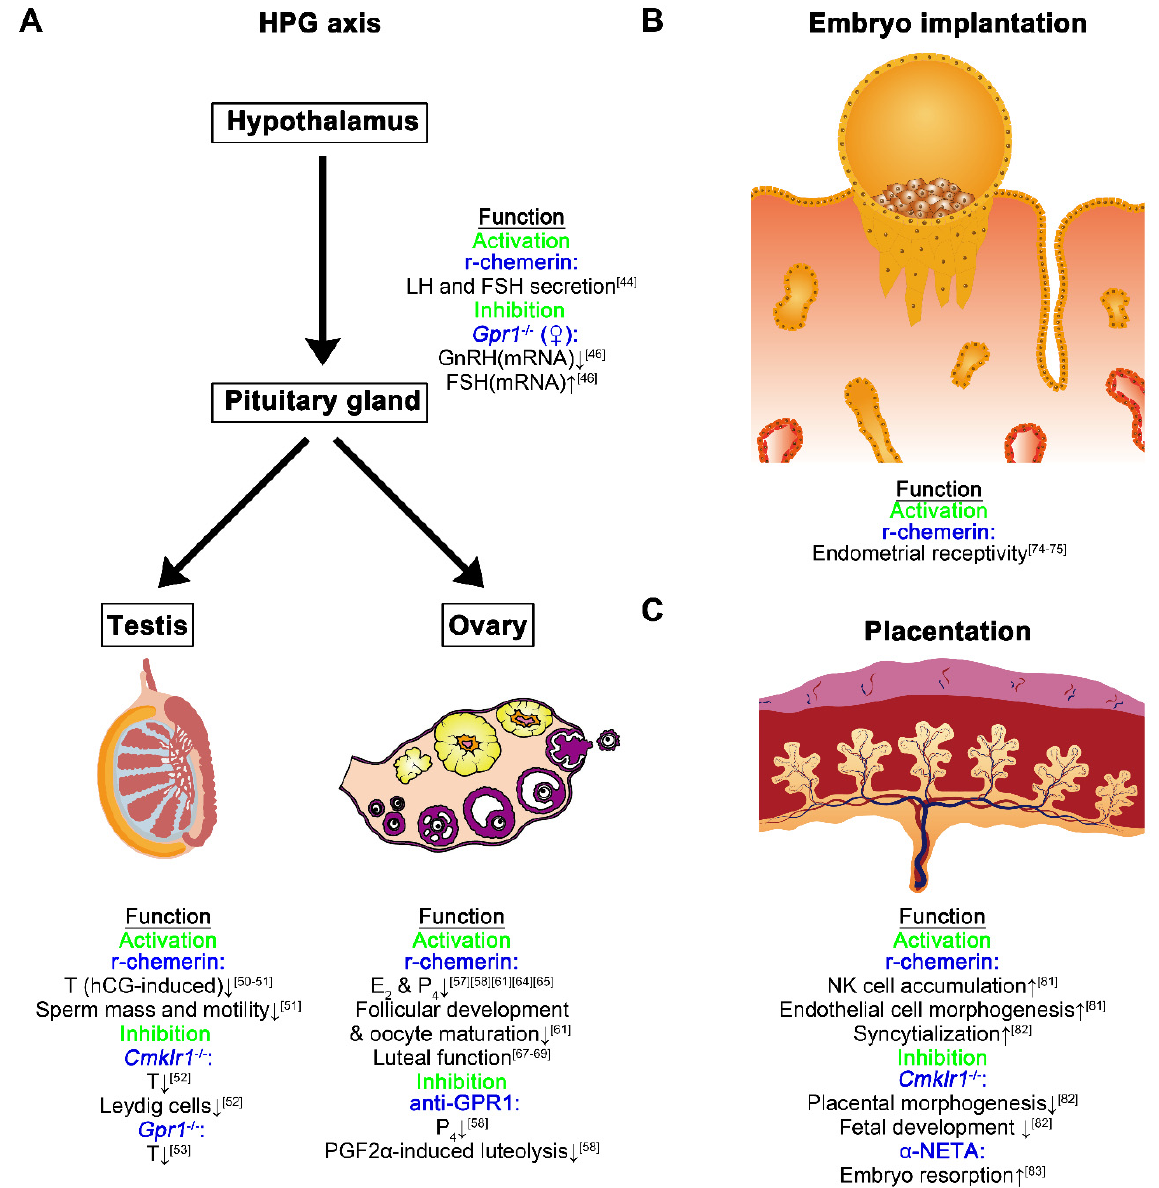
Figure 2. The biological functions of the chemerin system in physiological reproductive processes. The emerging information about the roles of the chemerin system in the HPG axis ( A ), embryo implantation ( B ), and placentation ( C ). r-chemerin, recombinant chemerin.